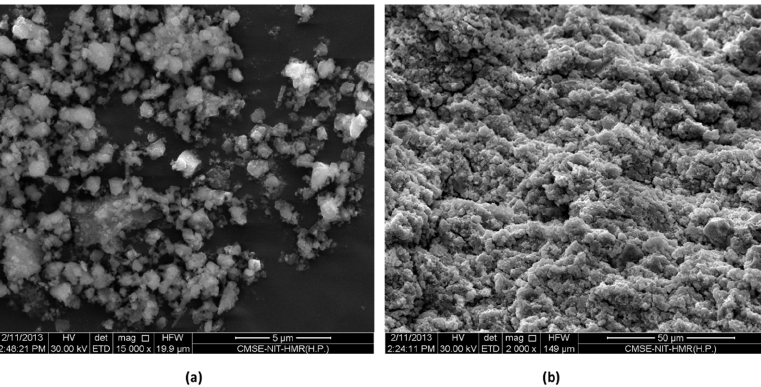
Figure 14. SEM images ( a ) HSR and ( b ) HEBM.